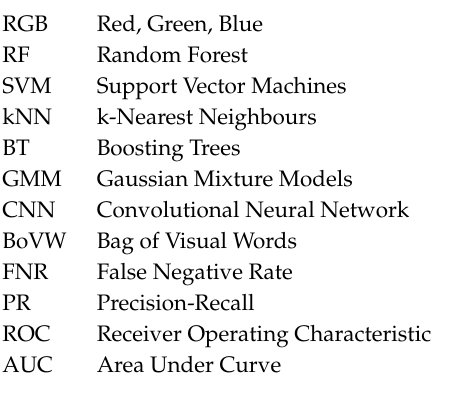
Table S1: Detailed cell density and composition of the used plankton